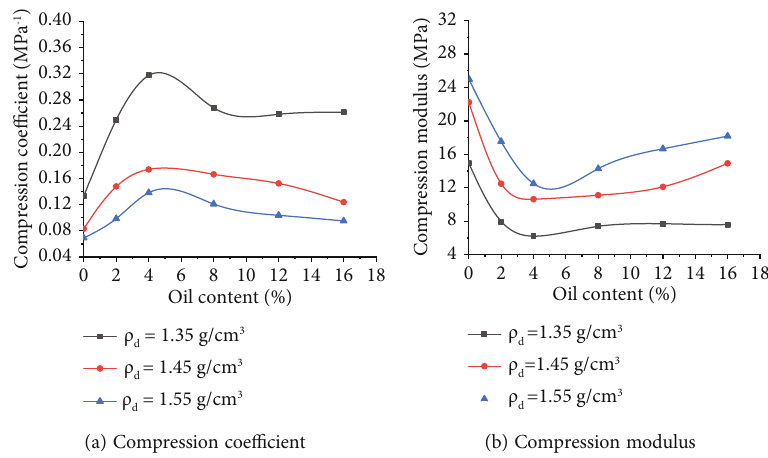
Figure 4: Compression characteristics of diesel-contaminated loess under the fi rst mode of oil contamination.